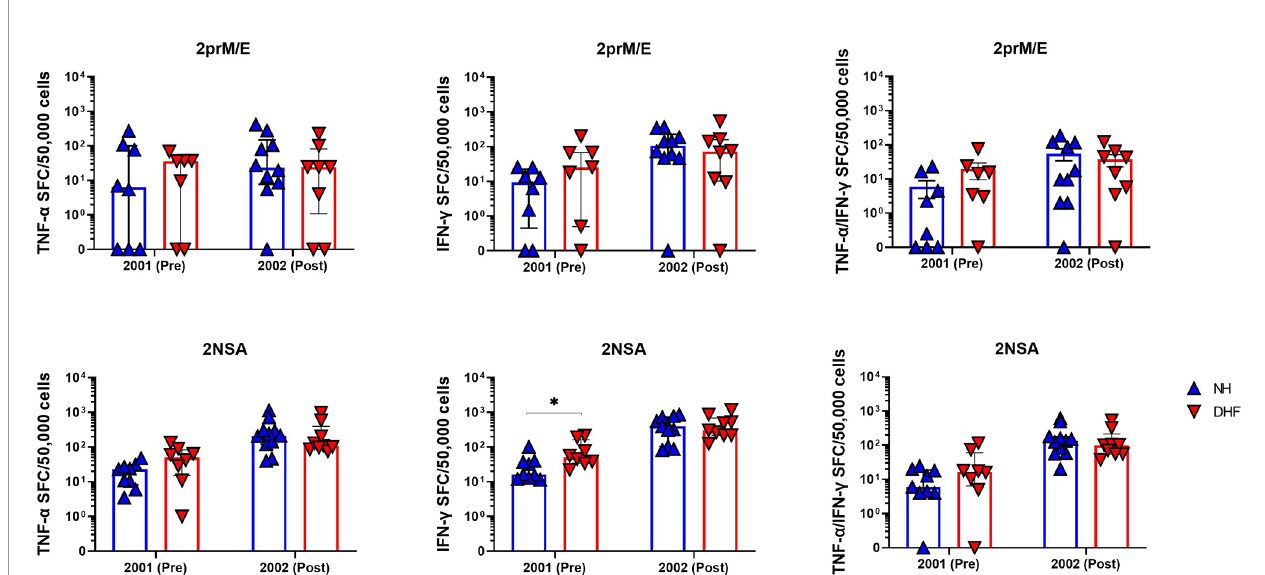
FIGURE 3 | Higher DENV-speci fi c T cell responses prior to secondary infection in hospitalized DHF subjects than non-hospitalized subjects. Symbols represent the frequencies of cells producing TNF a (left), IFN g (middle), or both TNF a and IFN g (right) by cultured ELISPOT in PBMC collected before (pre) or after (post) secondary DENV infection. PBMC were stimulated with peptide pools corresponding to DENV2 prM and E proteins (2prM/E, top) or DENV2 NS1, NS3, and NS5 proteins (2NSA, bottom). Bars represent median + interquartile range. Statistics were calculated by the non-parametric Mann-Whitney test. *p <